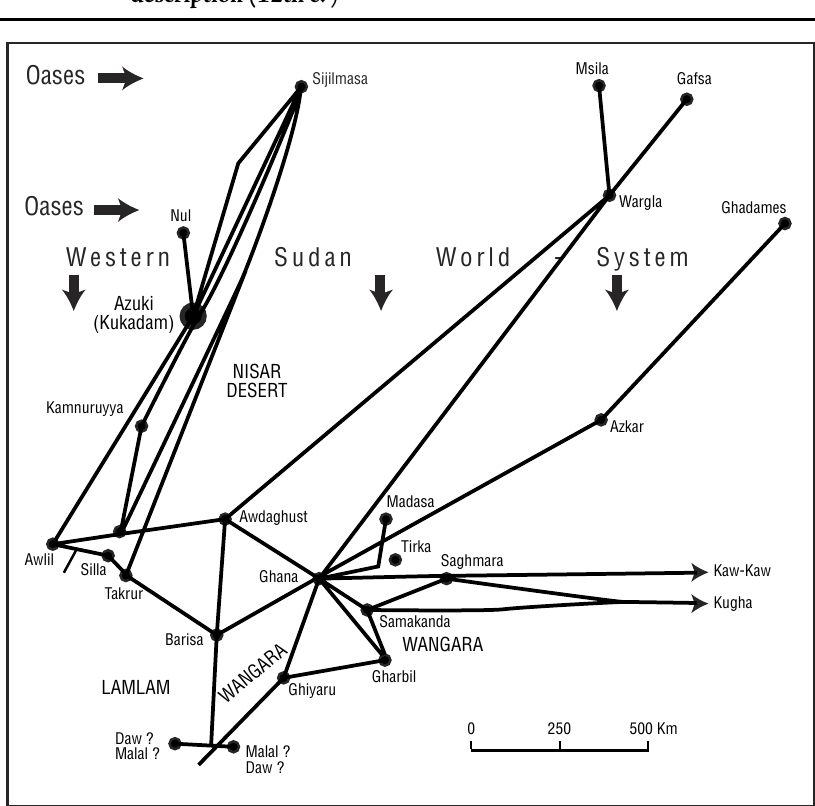
Figure 13 – Western Sudan interaction networks according to al-Idrisi's description (12th c.